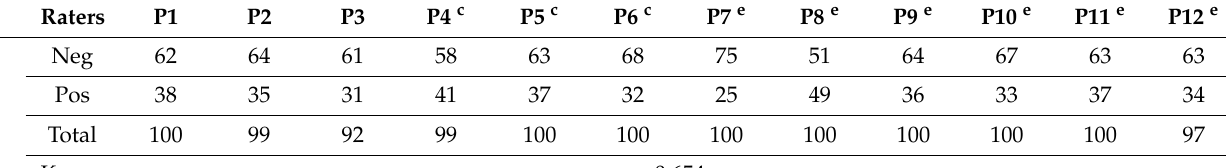
Table 2. Absolute agreement in scoring among raters in the two